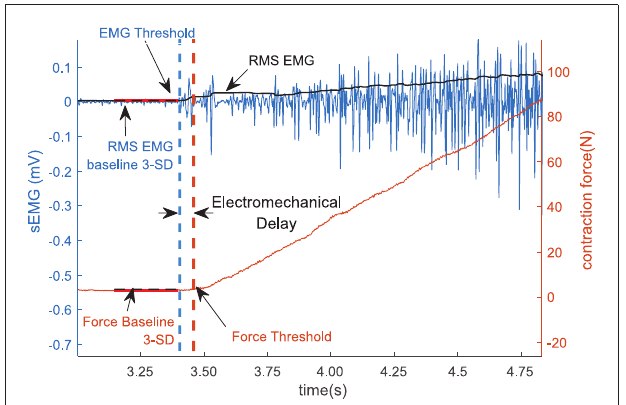
FIGURE 2 | The sEMG and the force threshold. The electromechanical delay (EMD) is denoted as the difference within the sEMG and the force threshold. The sEMG is showed in the left vertical axis and the force is in the right axis.